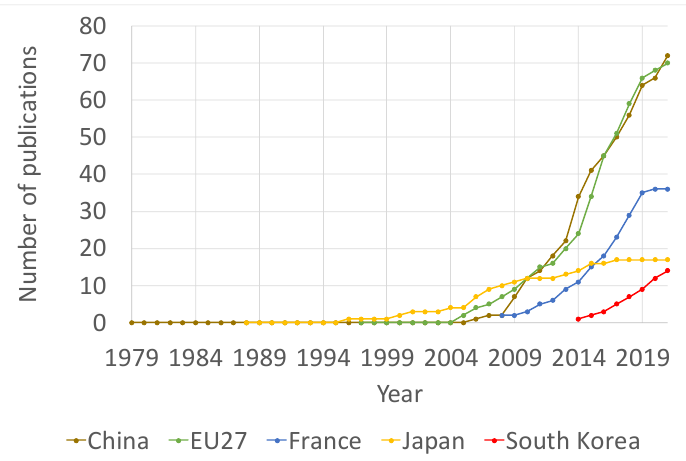
Figure 5. Trends of publications per top countries.